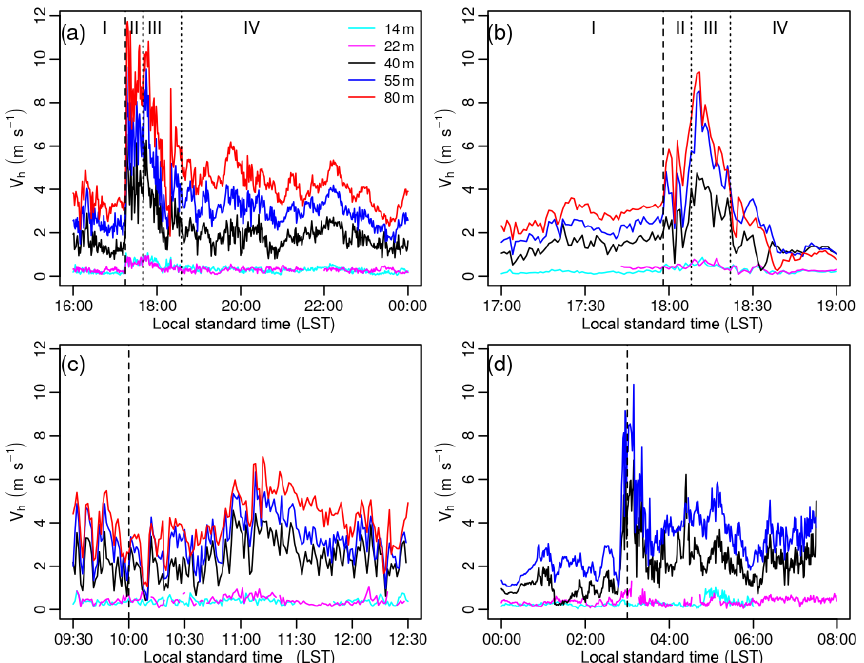
Figure 2. Temporal evolution of the mean horizontal wind speed at the different vertical levels, according to legend, for (a) event 1, (b) event 2, (c) event 3, and (d) event 4. The dashed vertical lines indicate the passage of the storm over or near the site at (a) 17:15LST, (b) 17:58LST, (c) 10:00LST, and (d) 03:00LST. The analysis of the cases I to IV is carried out in the